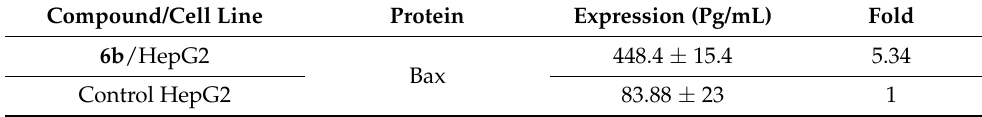
Table 4. Effect of compound 6b on the gene expression of Bax, Bcl-2, Caspase-3, and